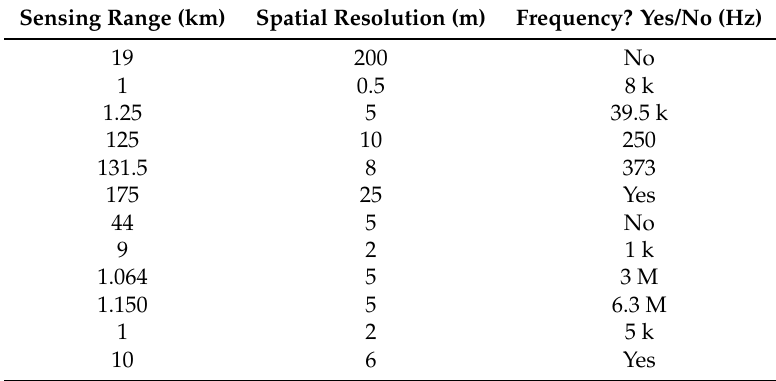
Table 3. Performance chart of various φ -OTDR-based systems. (Adapted from [17].) Sensing Range